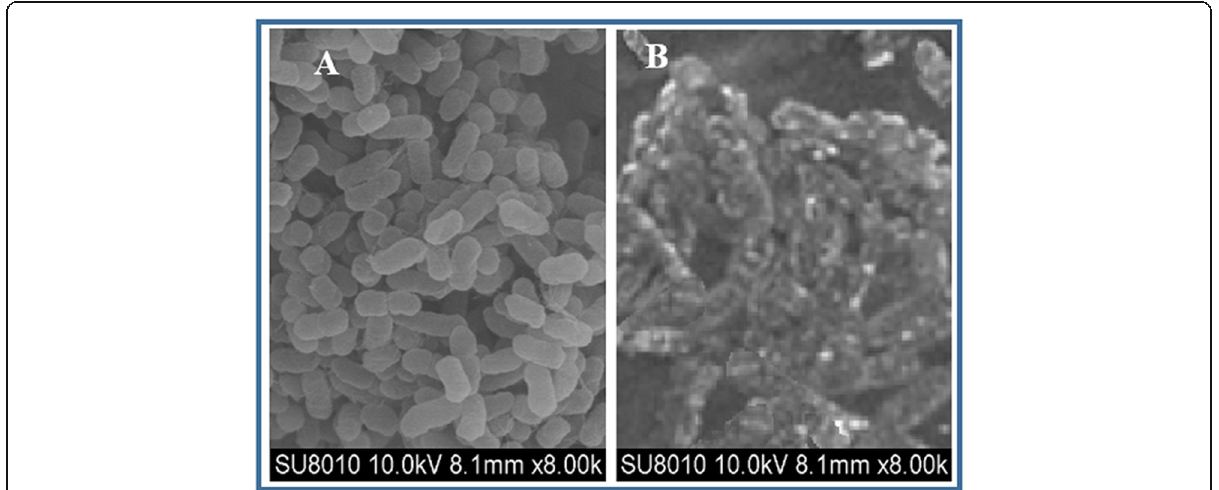
Fig. 2 Scanning electron images of R. solanacearum . a Control bacterial cells without treatment. b Bacterial cells treated with 9% fungal